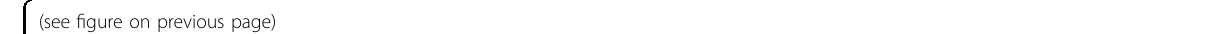
Fig. 1 Neurog2 converts dorsal midbrain astrocytes into neurons in vivo. a – b ″″ Double staining of mCherry and NeuN on sections of the dorsal midbrain from WT mice that were infected with the control virus AAV – mCherry ( a – a ″″ ) or AAV-Neurog2/mCherry ( b – b ″″ ) on day 3. c – d ″″ Double staining of mCherry and NeuN on sections of the dorsal midbrain from WT mice that were infected with the control virus AAV – mCherry ( c – c ″″ ) or AAV-Neurog2/mCherry ( d – d ″″ ) on day 10. e – f ″″ Double staining of mCherry and NeuN on sections of the dorsal midbrain from WT mice that were infected with the control virus AAV – mCherry ( e – e ″″ ) or AAV-Neurog2/mCherry ( f – f ″″ ) on day 30. Panels ( a ″″ , b ″″ , c ″″ , d ″″ , e ″″ , f ″″ ) are higher magni fi cations of the boxed areas in ( a ″ ′ , b ″ ′ , c ″ ′ , d ″ ′ , e ″ ′ , f ″ ′ ), respectively. mCherry was not colocalized with NeuN (arrowheads). mCherry colocalized with NeuN (arrows). g The statistical data of astrocyte-to-neuron conversion ef fi ciency induced by Neurog2 at different time points. A one-way ANOVA revealed a signi fi cant effect of group (F[5,17] = 493.2, p < 0.001), followed by Tukey ’ s multiple comparison test. *** Represents p < 0.001; scale bars: 50 μ m ( a ″ ′ , b ″ ′ , c ″ ′ , d ″ ′ , e ″ ′ , f ″ ′ ) and 25 μ m ( a ″″ , b ″″ , c ″″ , d ″″ , e ″″ , f ″″ ). h – h ″ 3D images of ( f ″″ ): ( h ) front view of ( f ″″ ), ( h ′ )